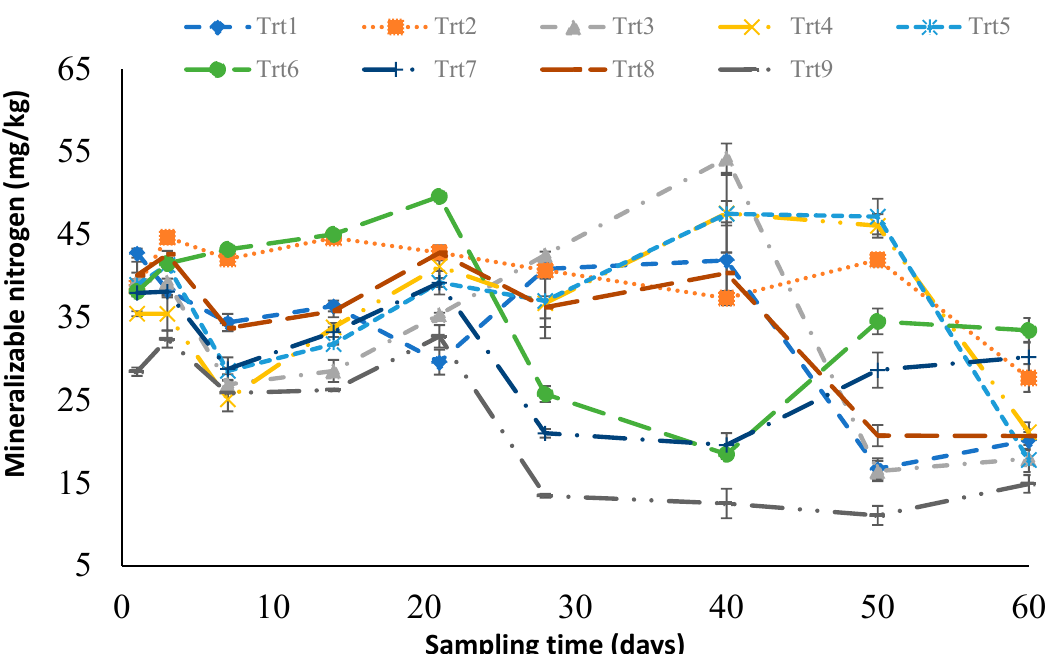
Figure 7. The NH 4 -N + NO 3 -N (mineralizable N) released in soils during incubation at different rates of compost application. Key: Trt1: 3:1 − IMO at 5 t ha − 1 , Trt2: 3:1 − IMO at 10 t ha − 1 , Trt3: 1:2 − IMO at 5 t ha − 1 , Trt4: 1:2 − IMO at 10 t ha − 1 , Trt5: 3:1 + IMO at 5 t ha − 1 , Trt6: 3:1 + IMO at10 t ha − 1 , Trt7: 1:2 + IMO at 5 t ha − 1 , Trt8: 1:2 + IMO at 10 t ha − 1 , Trt9: control.